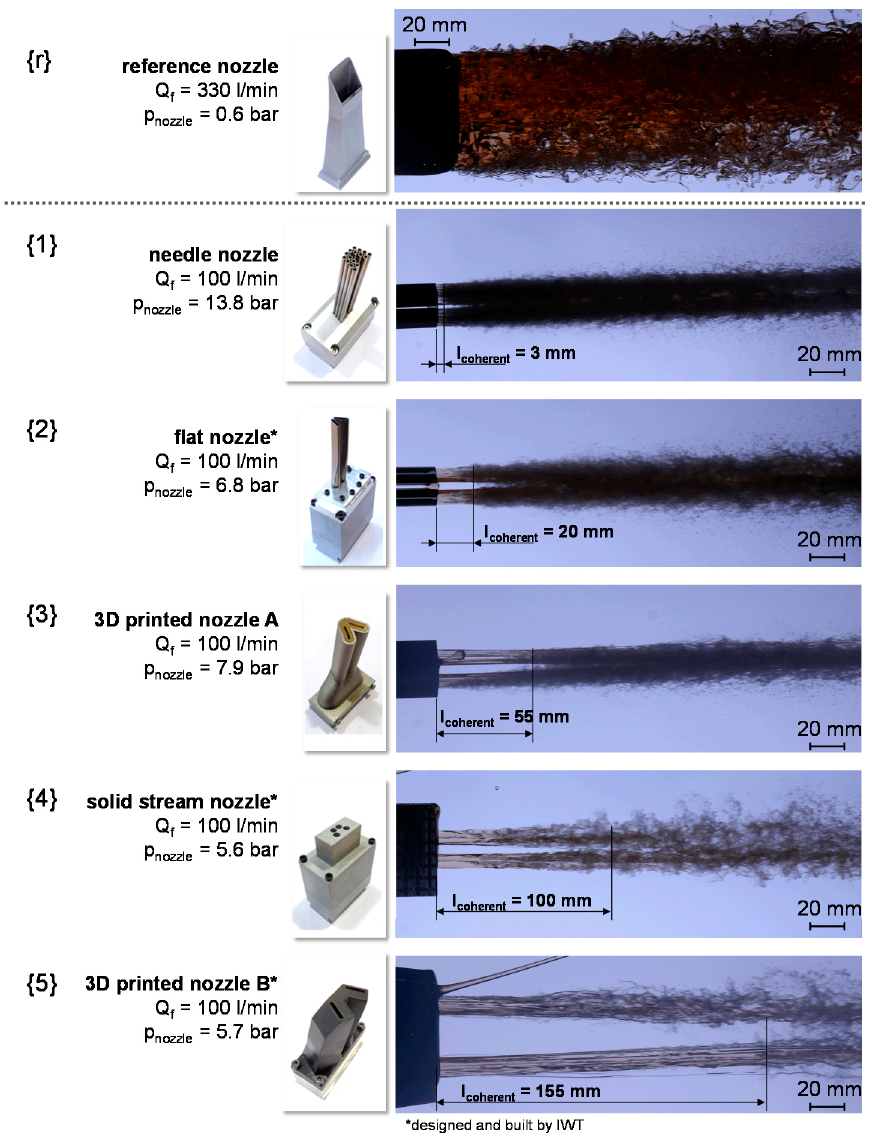
Figure 7. Characterization of fluid supply nozzles—coherent jet lengths.